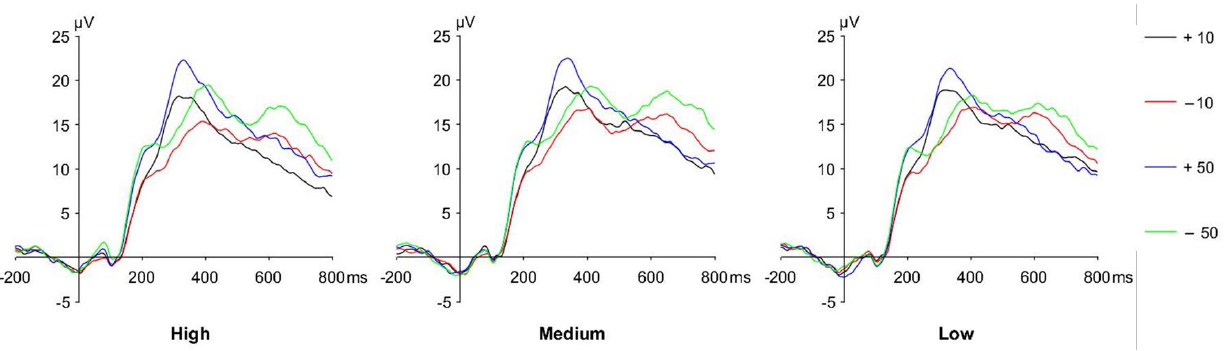
Figure 3. The risky ratio of different time pressures. Error bar = 95% confidence interval. The grand average ERP waveforms induced by 3 different time constraint conditions (High, Medium, Low) and 4 different outcome stimuli (+10, − 10, +50, − 50) are depicted in Figure 4.